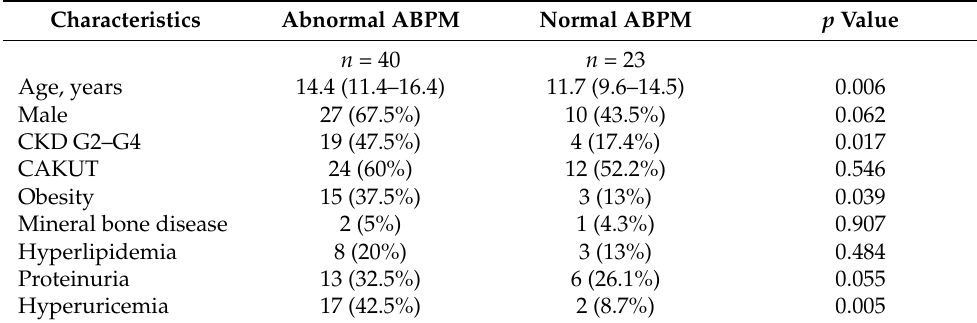
Table 2. Comparison of the clinical characteristics and CKD complications in children with CKD stratified for abnormal and normal ABPM profile.